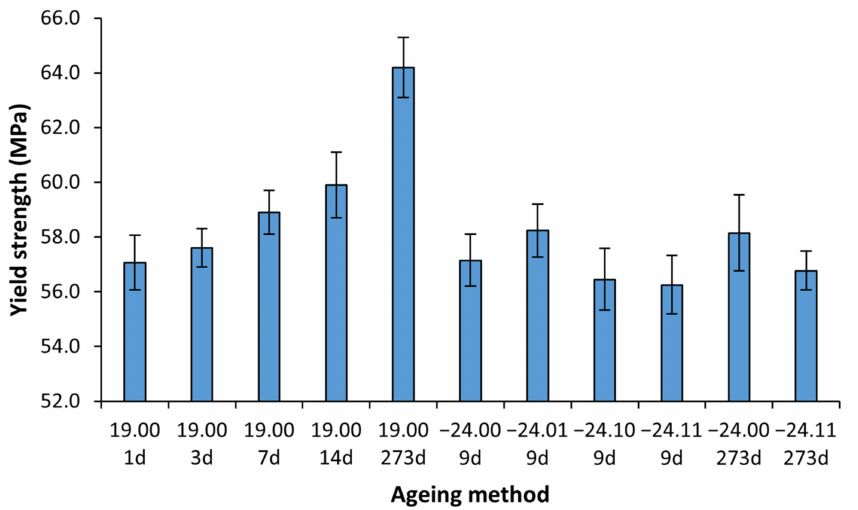
Figure 9. Bar diagram with the average value of the yield strength with its mean square error versus the ageing time. The Shadow area shows the frozen sample value interval. Six samples were measured for each ageing conditions and error bars are the standard